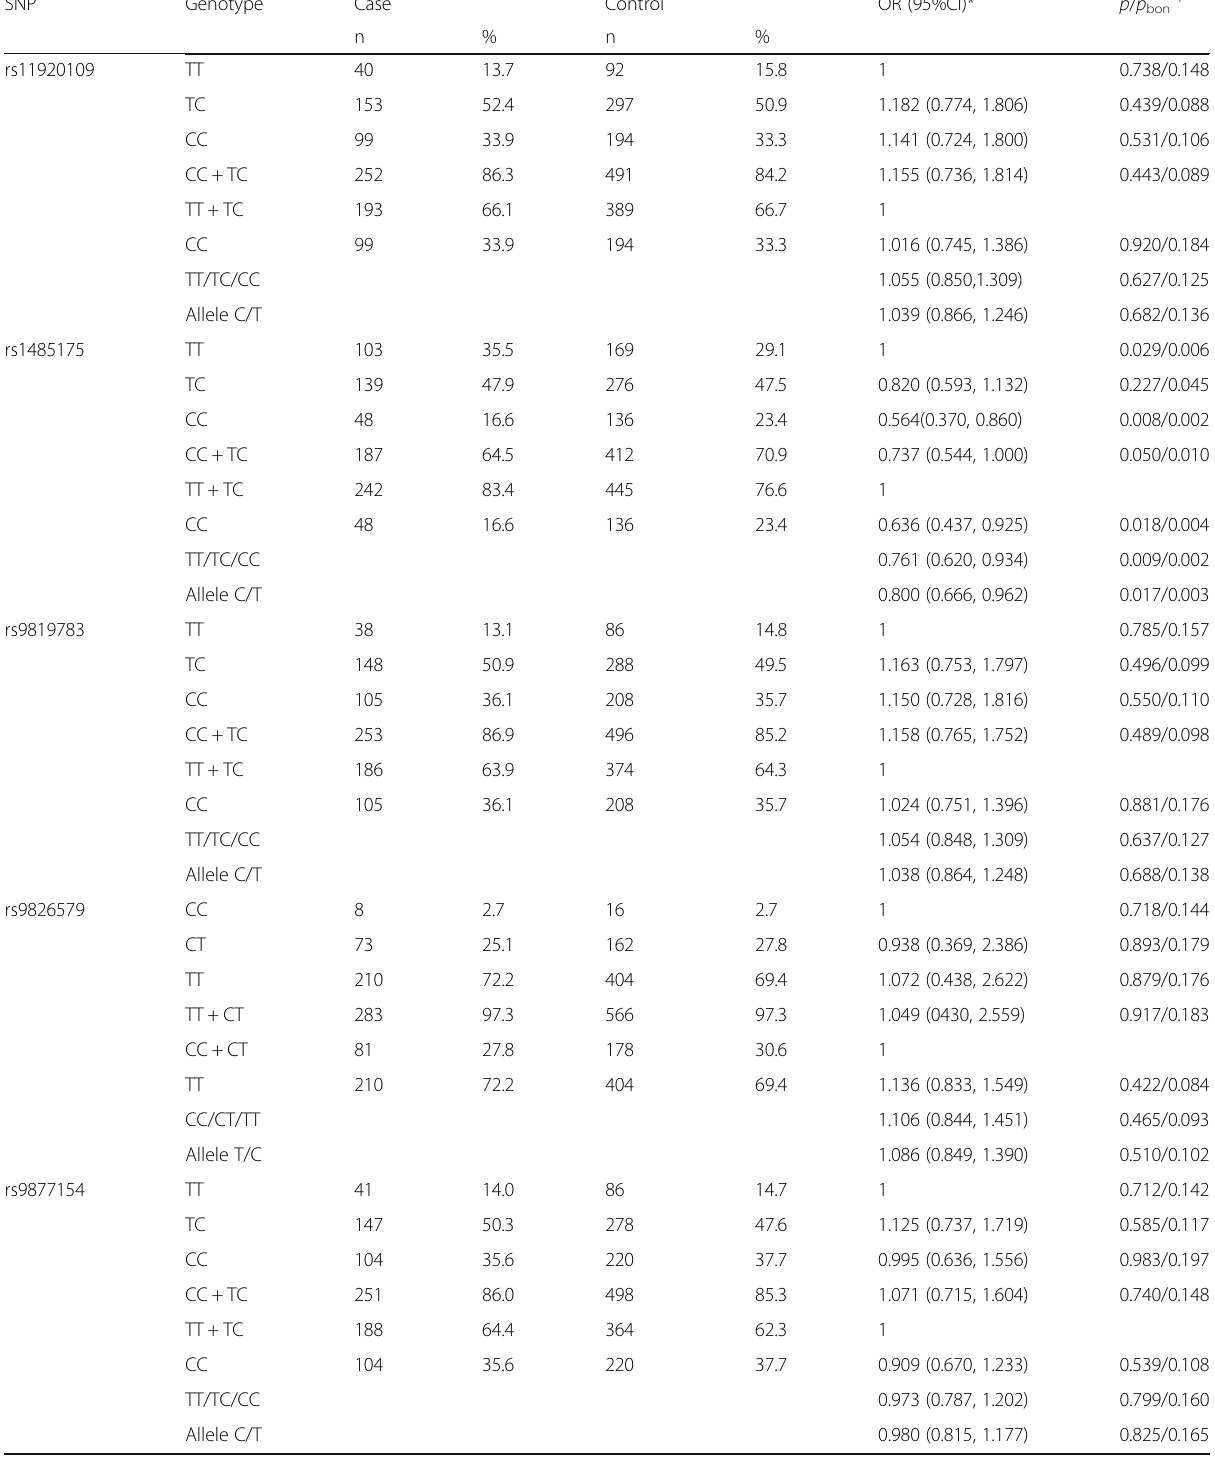
Table 3 Correlation of Genetic Models with Risk of Developing